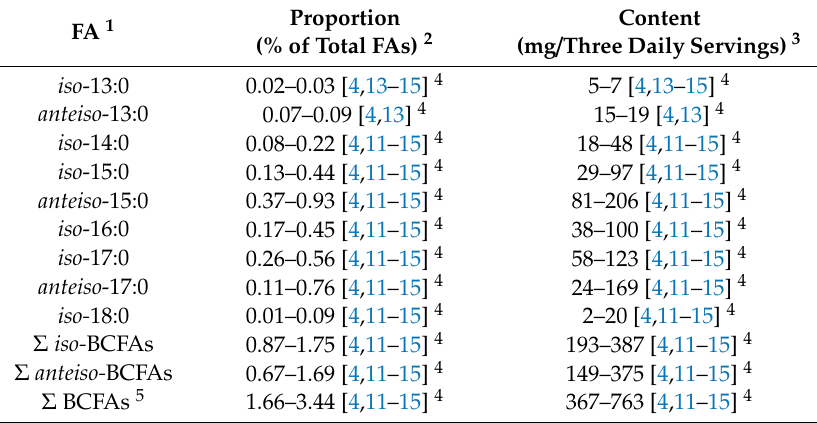
Table 1. Branched-chain fatty acid composition and content of cow’s